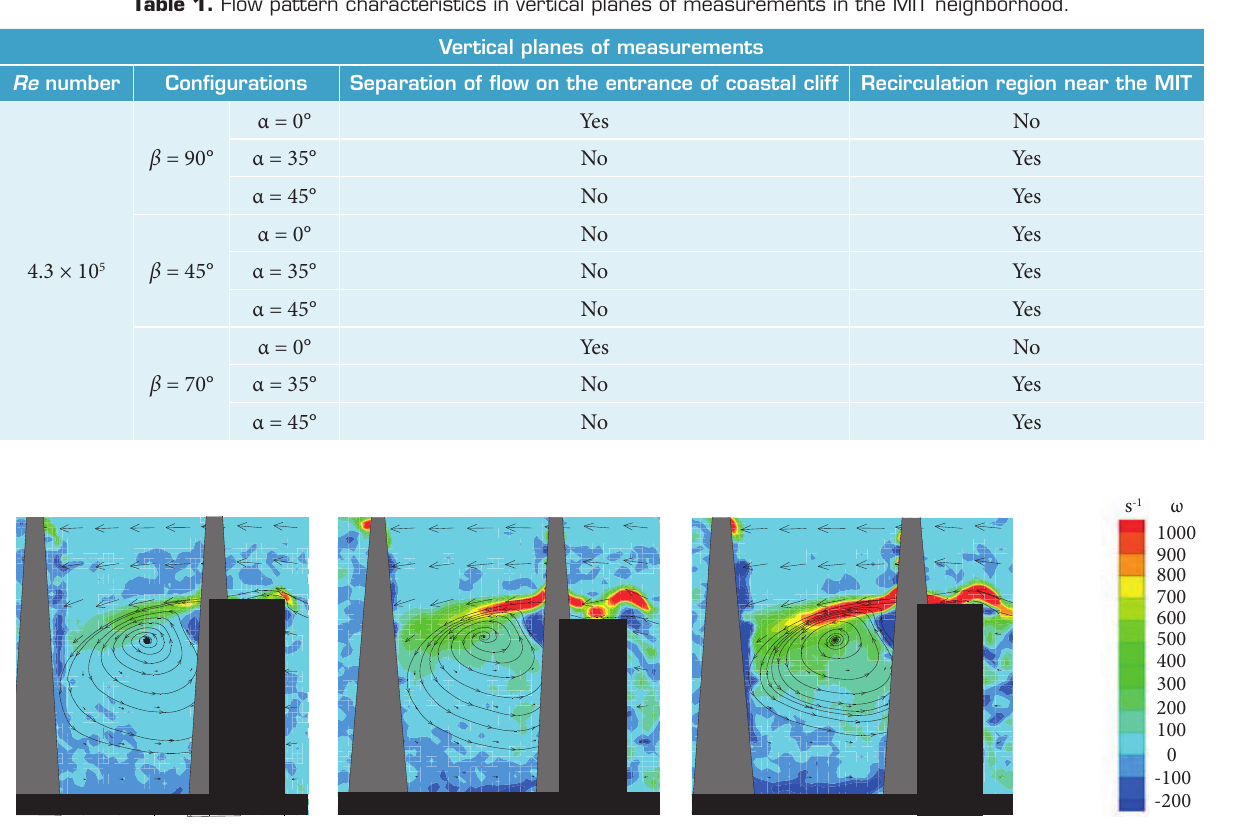
Figure 21. Vorticity contours and velocity vectors – β = 45° and α = 45°, and varying the Re